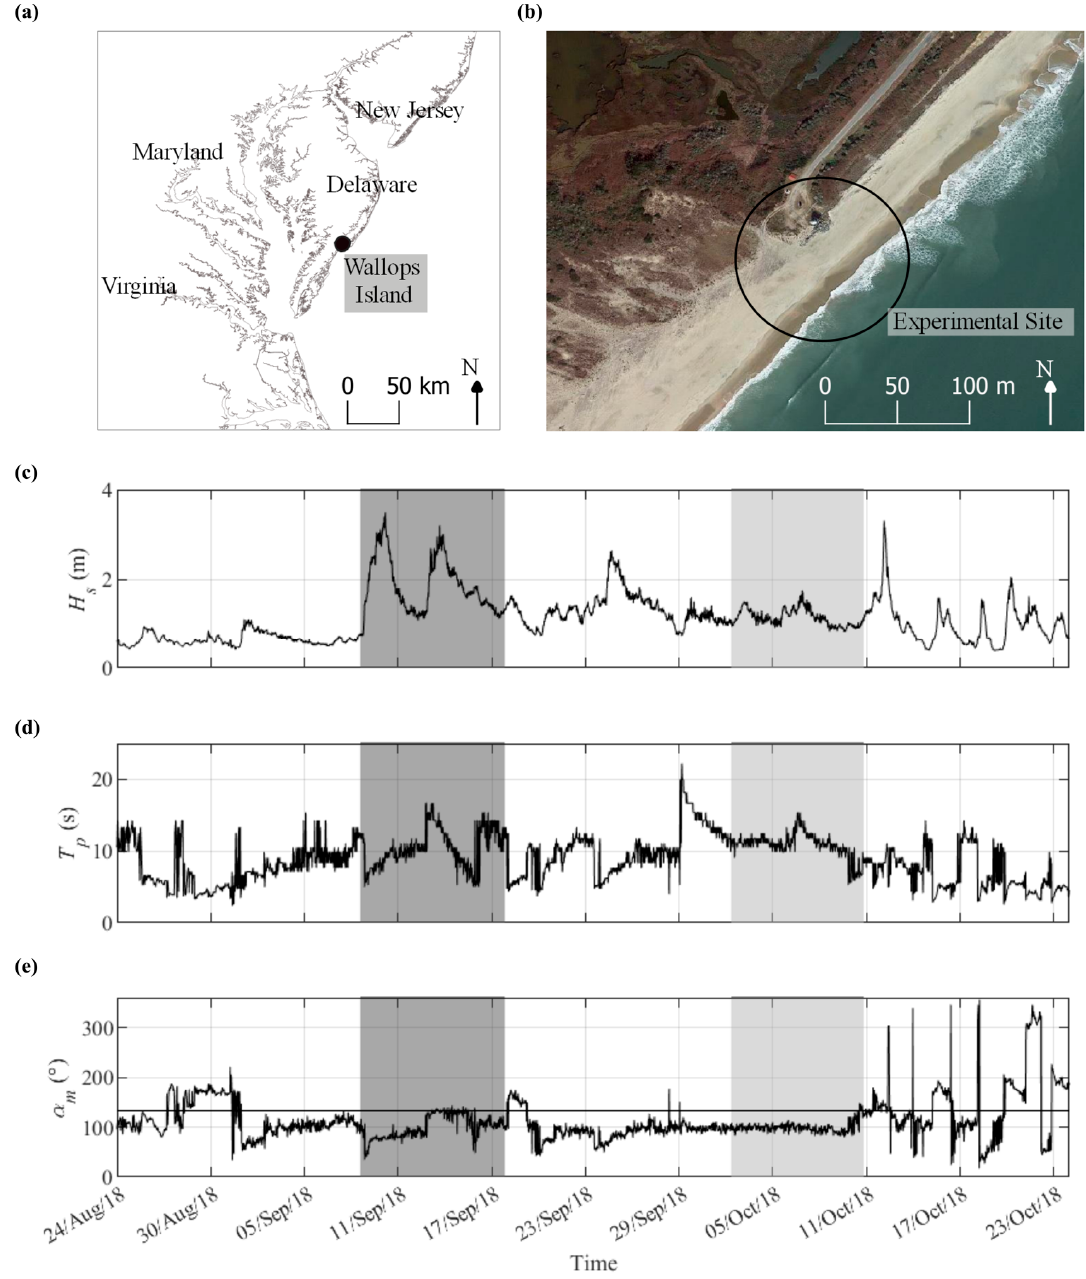
Figure 10. Map representing the Delmarva region ( a ) and a picture of the field site ( b ). Significant wave height ( c ), peak wave period ( d ) and mean wave direction ( e ) during the study. Direction units are degrees from true North, increasing clockwise, with North as 0° and East as 90°. Solid straight line in panel E indicates the shore normal direction (133°). Shaded time windows represent Hurricane Florence and the force balance munition testing time, respectively. Data are provided by the NOAA National Data Buoy Center; station 44089—Wallops Island (VA).